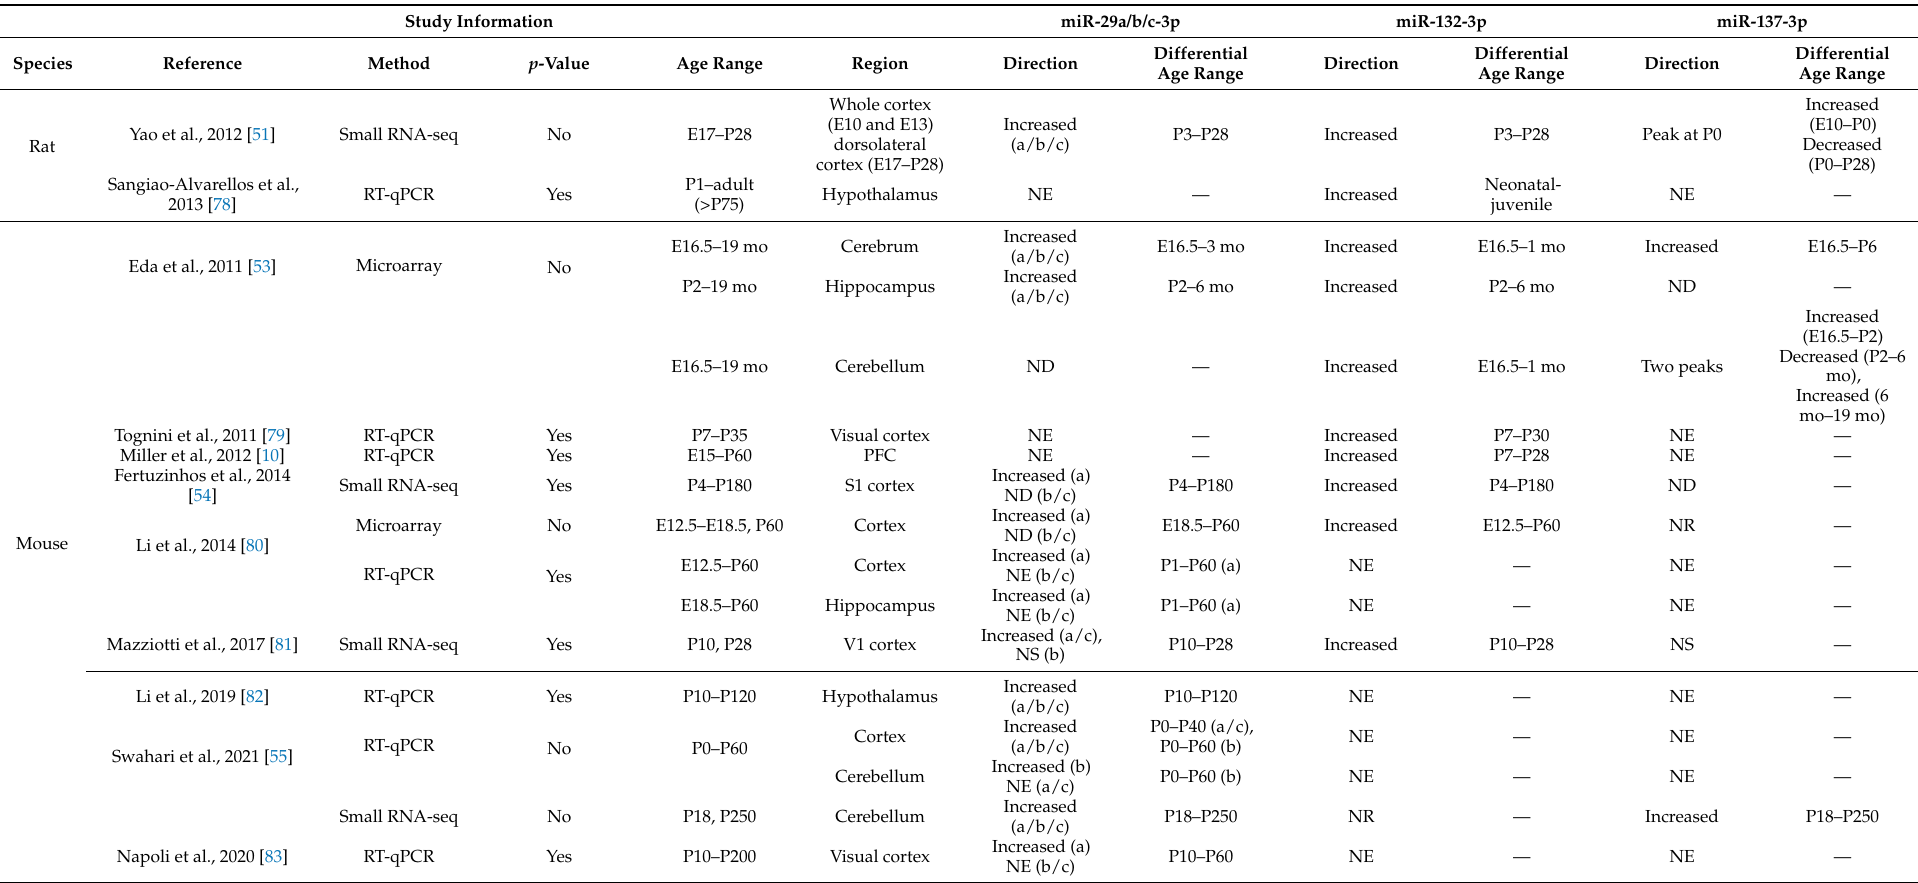
Table 3. Changes in specific miRNAs with age in rodent